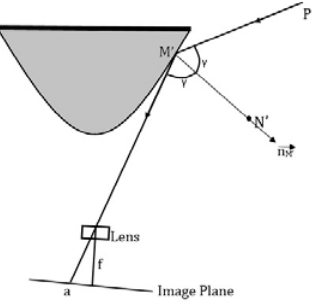
Figure 8. CP reflection on mirror and imaged on the